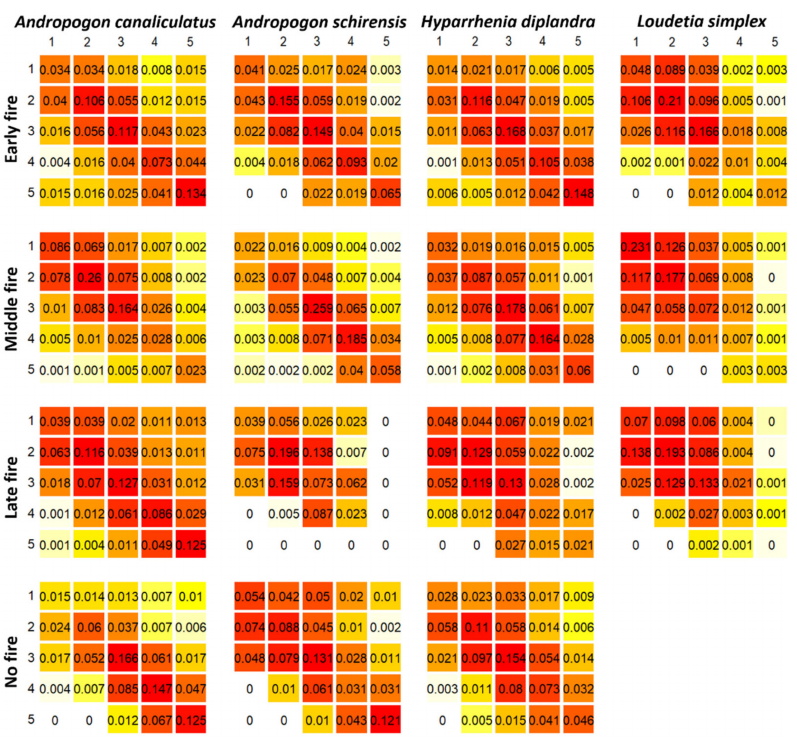
Figure 2. Elasticity matrices of all species in the four fire treatments. The redder the color, the higher the value.